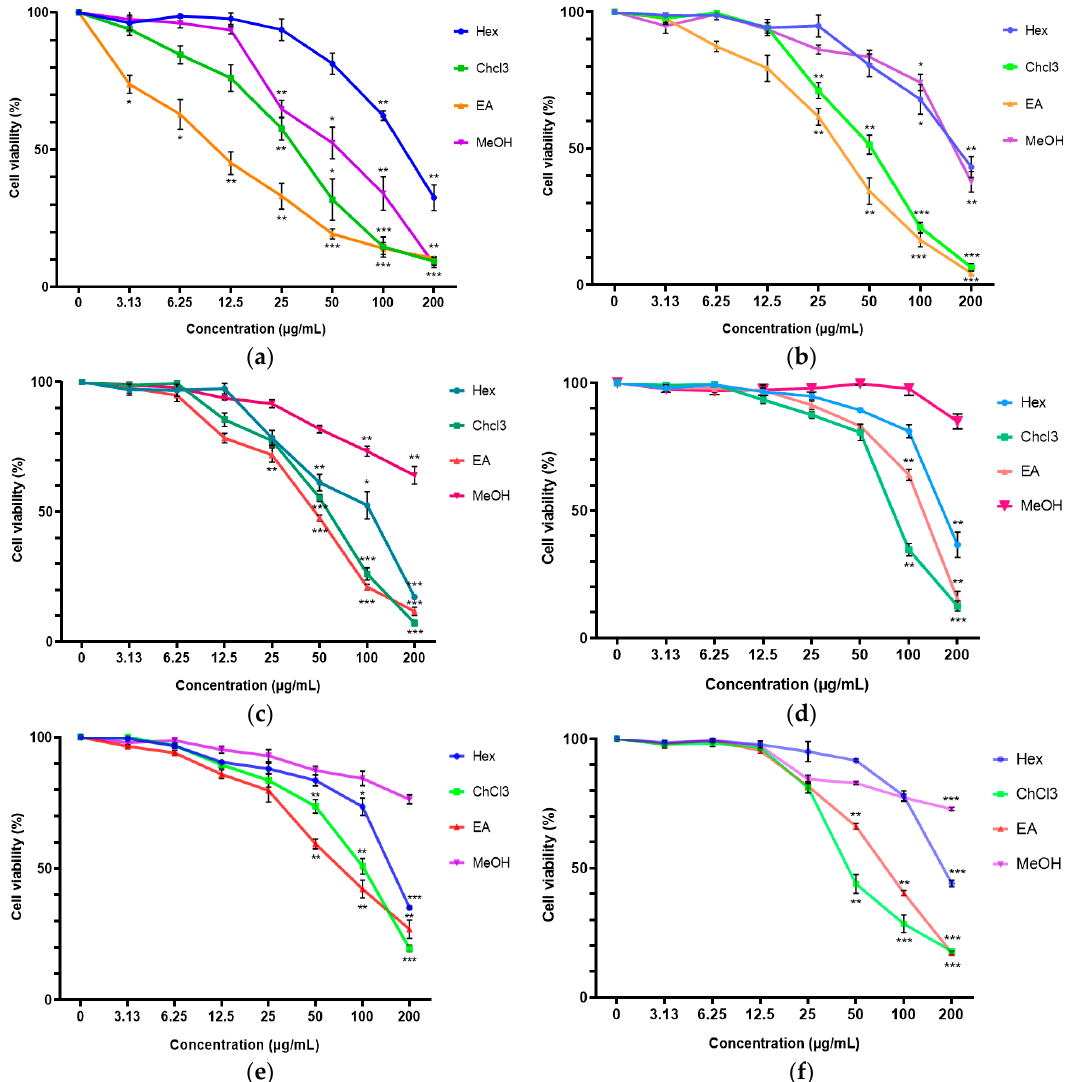
Figure 1. Cytotoxicity of C. vespertilionis extracts determined using an MTT assay; ( a ) root extracts on MDA-MB-231, ( b ) leaf extracts on MDA-MB-231, ( c ) root extracts on MCF-7, ( d ) leaf extracts on MCF-7, ( e ) root extracts on 3T3, and ( f ) leaf extracts on 3T3 cell lines. Hex, ChCl3, EA and MeOH represents the hexane, chloroform, ethyl acetate and methanol extract, respectively. All values are expressed as mean ± SD and data with asterisks are significantly different at p < 0.05 when compared with the untreated group (control).